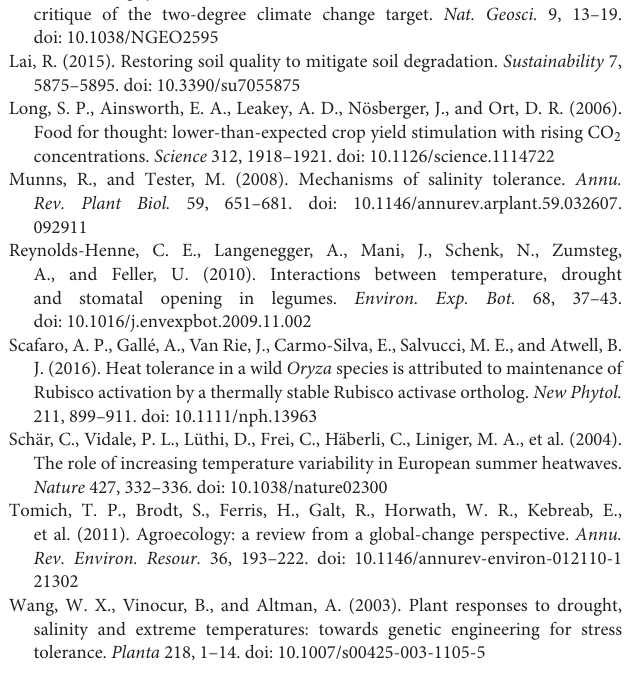
(f) Identification of key proteins/genes for breeding (potential for